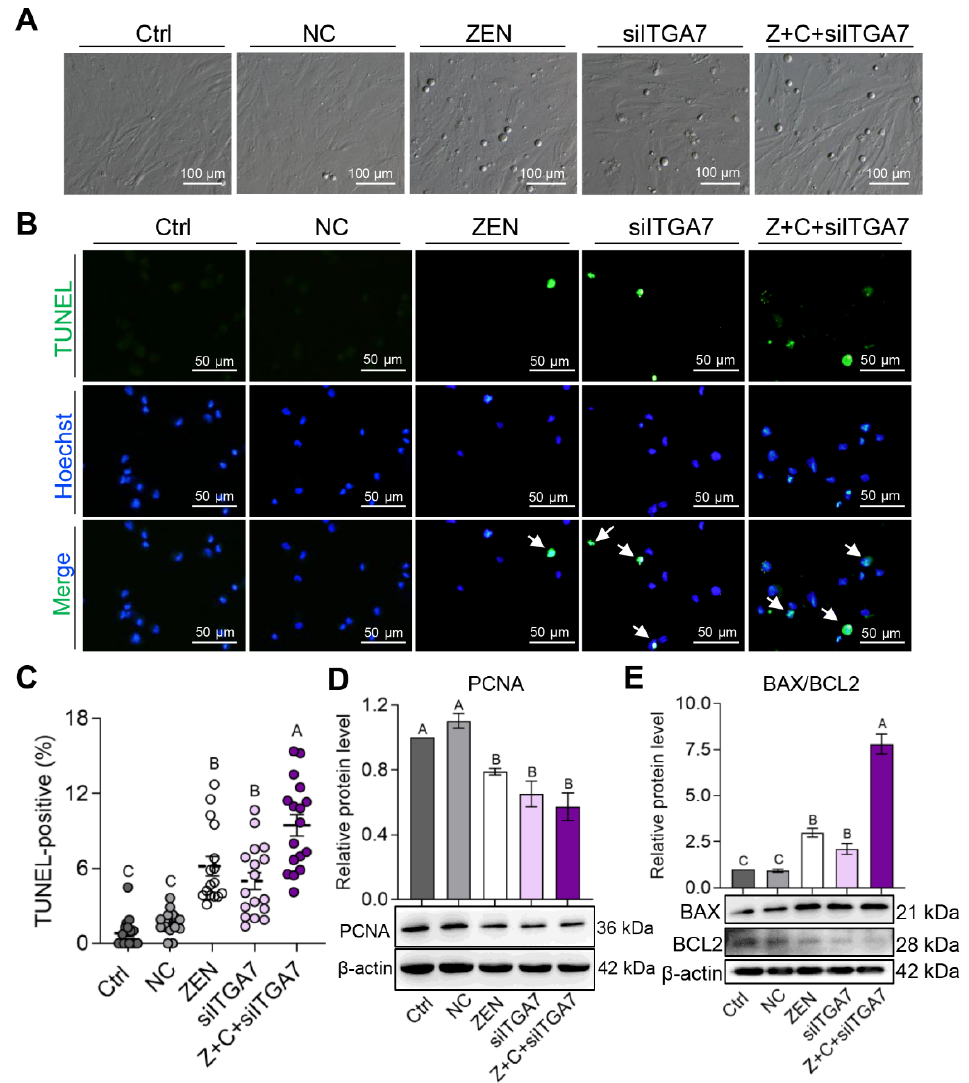
Figure 6. C3G rescues proliferation inhibition and apoptosis caused by ZEN via the ITGA7-PI3K- AKT signaling pathway in pGCs. ( A ) Bright field imaging of pGCs in Ctrl, NC, ZEN, siITGA7, and Z+C+siITGA7 groups; scale bar = 100 µm. ( B ) Immunostaining of TUNEL (green) in the 5 groups of pGCs. Nuclei were counterstained with Hoechst (blue). The white arrows represent positive cells; scale bar = 50 µm. ( C ) Representative results of TUNEL-positive cell proportion determined from images in ( B ); n = 16, 16, 16, 17, and 17, respectively. ( D ) WB showing relative protein levels of PCNA from the 5 groups in pGCs (β -actin as the internal reference). ( E ) WB showing relative protein level of BAX/BCL2 from pGCs of the 5 groups (β -actin as the internal reference); n = 3. All results are presented as means ± SEM. Labels (A, B, C) indicate highly significantly different values ( p < 0.01).